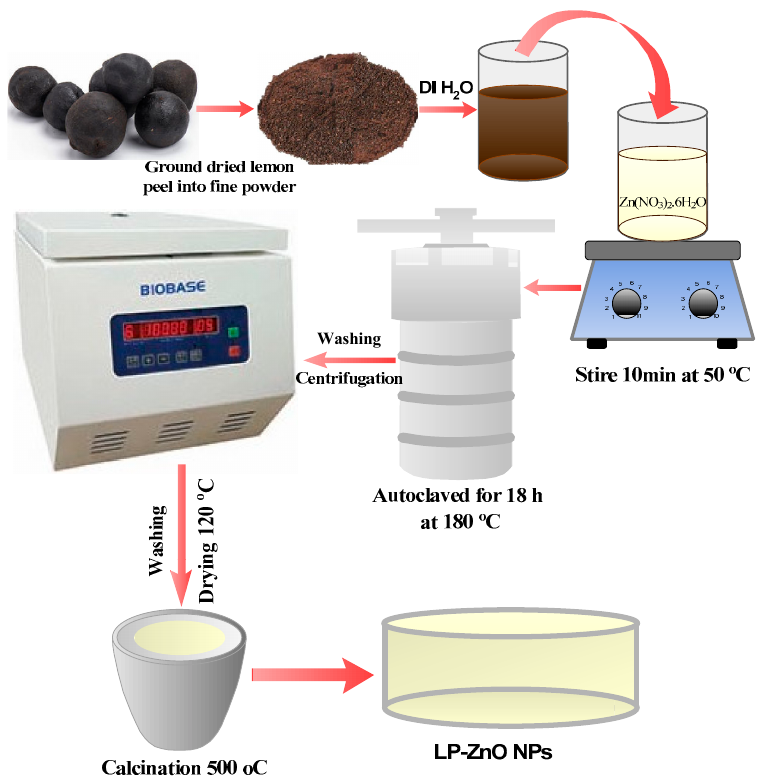
Figure 1. Schematic representation of the preparation of LP-ZnO NPs.